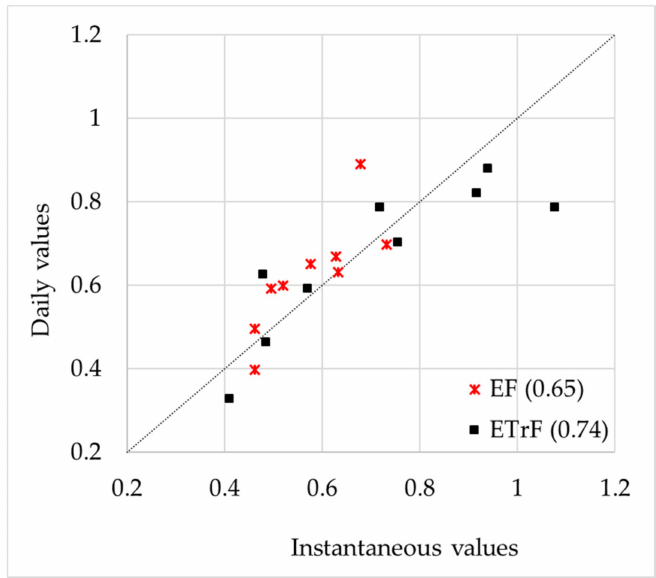
Figure 11. Validation of net radiation for 2014.